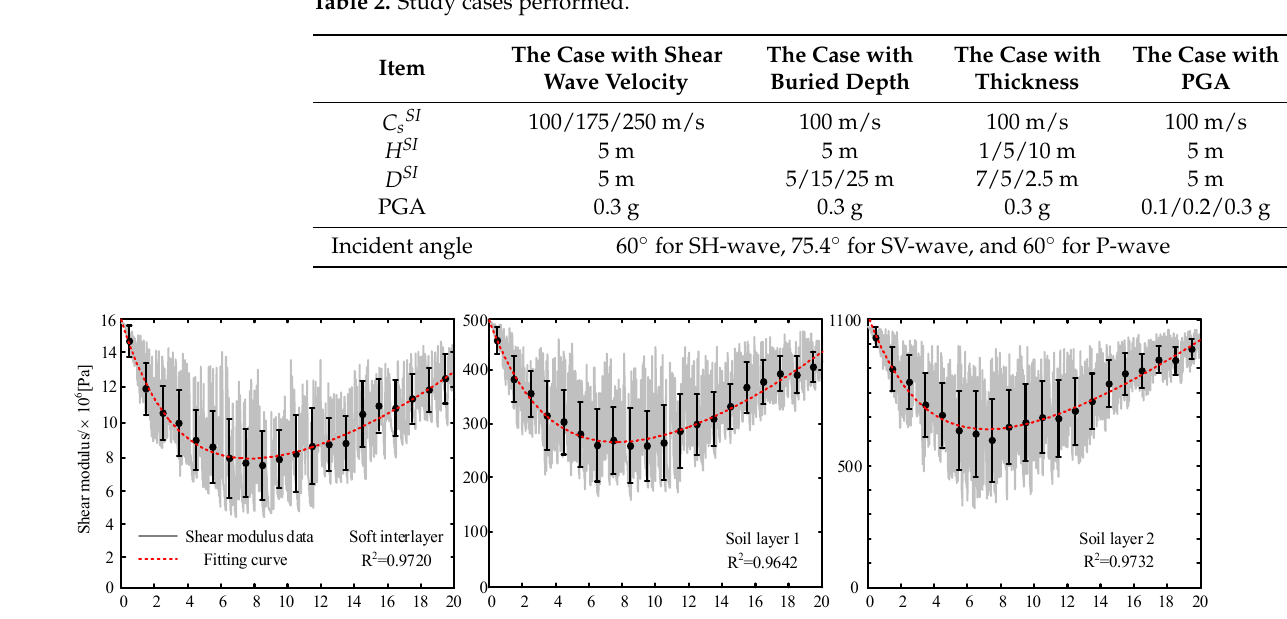
Table 2. Study cases performed.